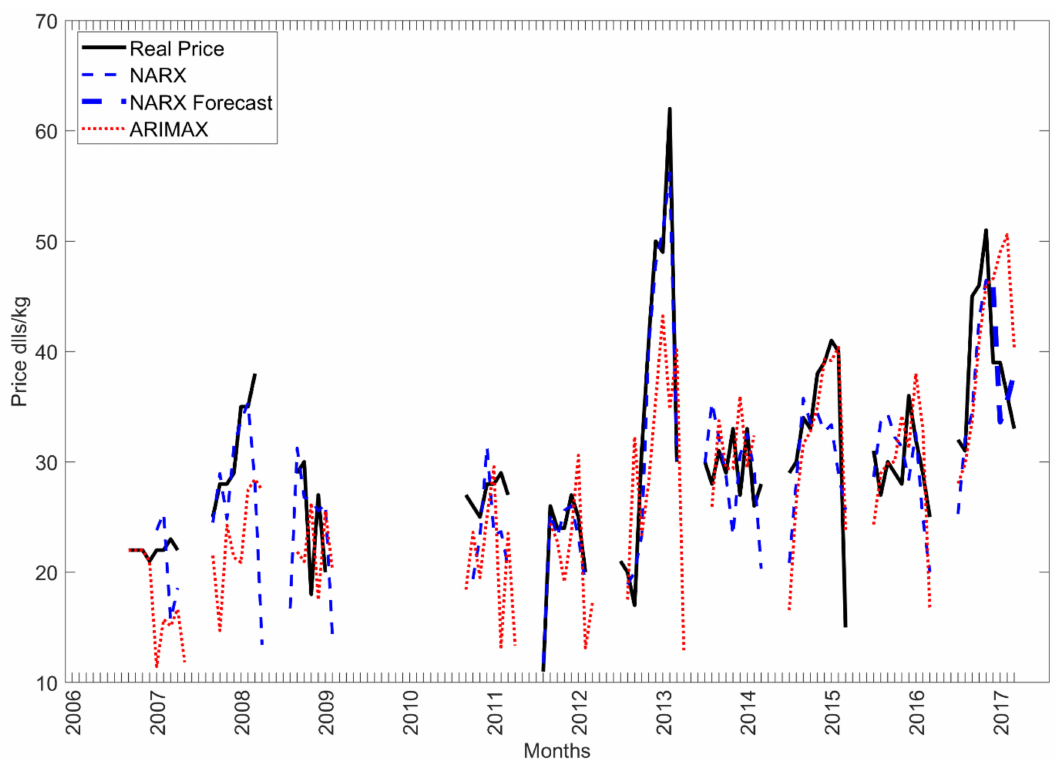
Figure 5. Regression fit of the NARX (dashed line) and ARIMAX (dot line) models with the exogenous variable export volume of Mexican lobster to China from January 2006 to December 2016, the historical variability of the export price data of Mexican lobster to China (black line) from January 2006 to March 2017, and the prediction of the NARX (thick dashed line) and ARIMAX (magenta line) models for the first three months of